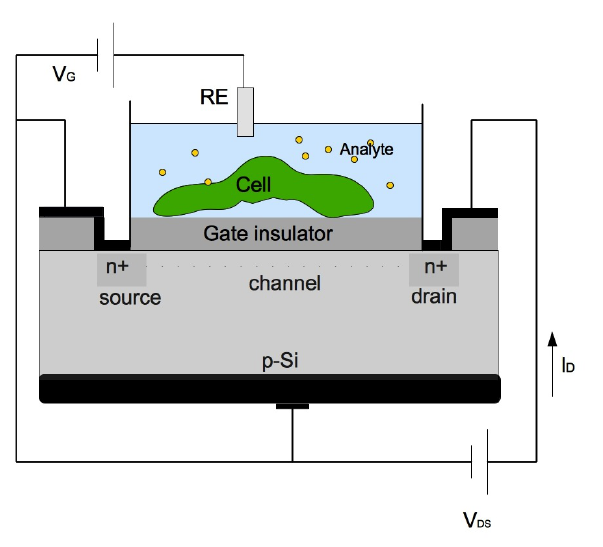
Figure 2. Cell/transistor hybrid. The open gate area of the FET is completely covered by one cell as indicated in the schematics (RE: reference electrode; VG: gate voltage; VDS: drain-source voltage; ID: drain